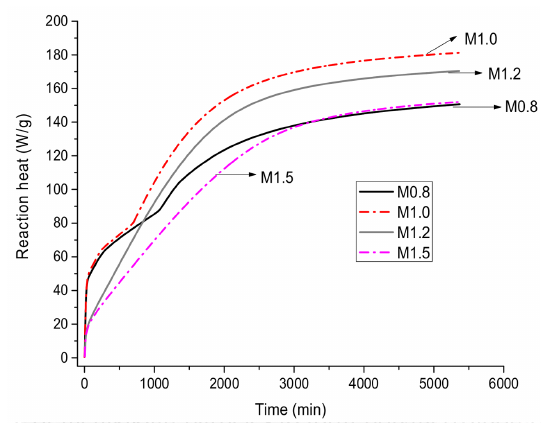
Figure 16. Cumulative heat of the geopolymer coating.